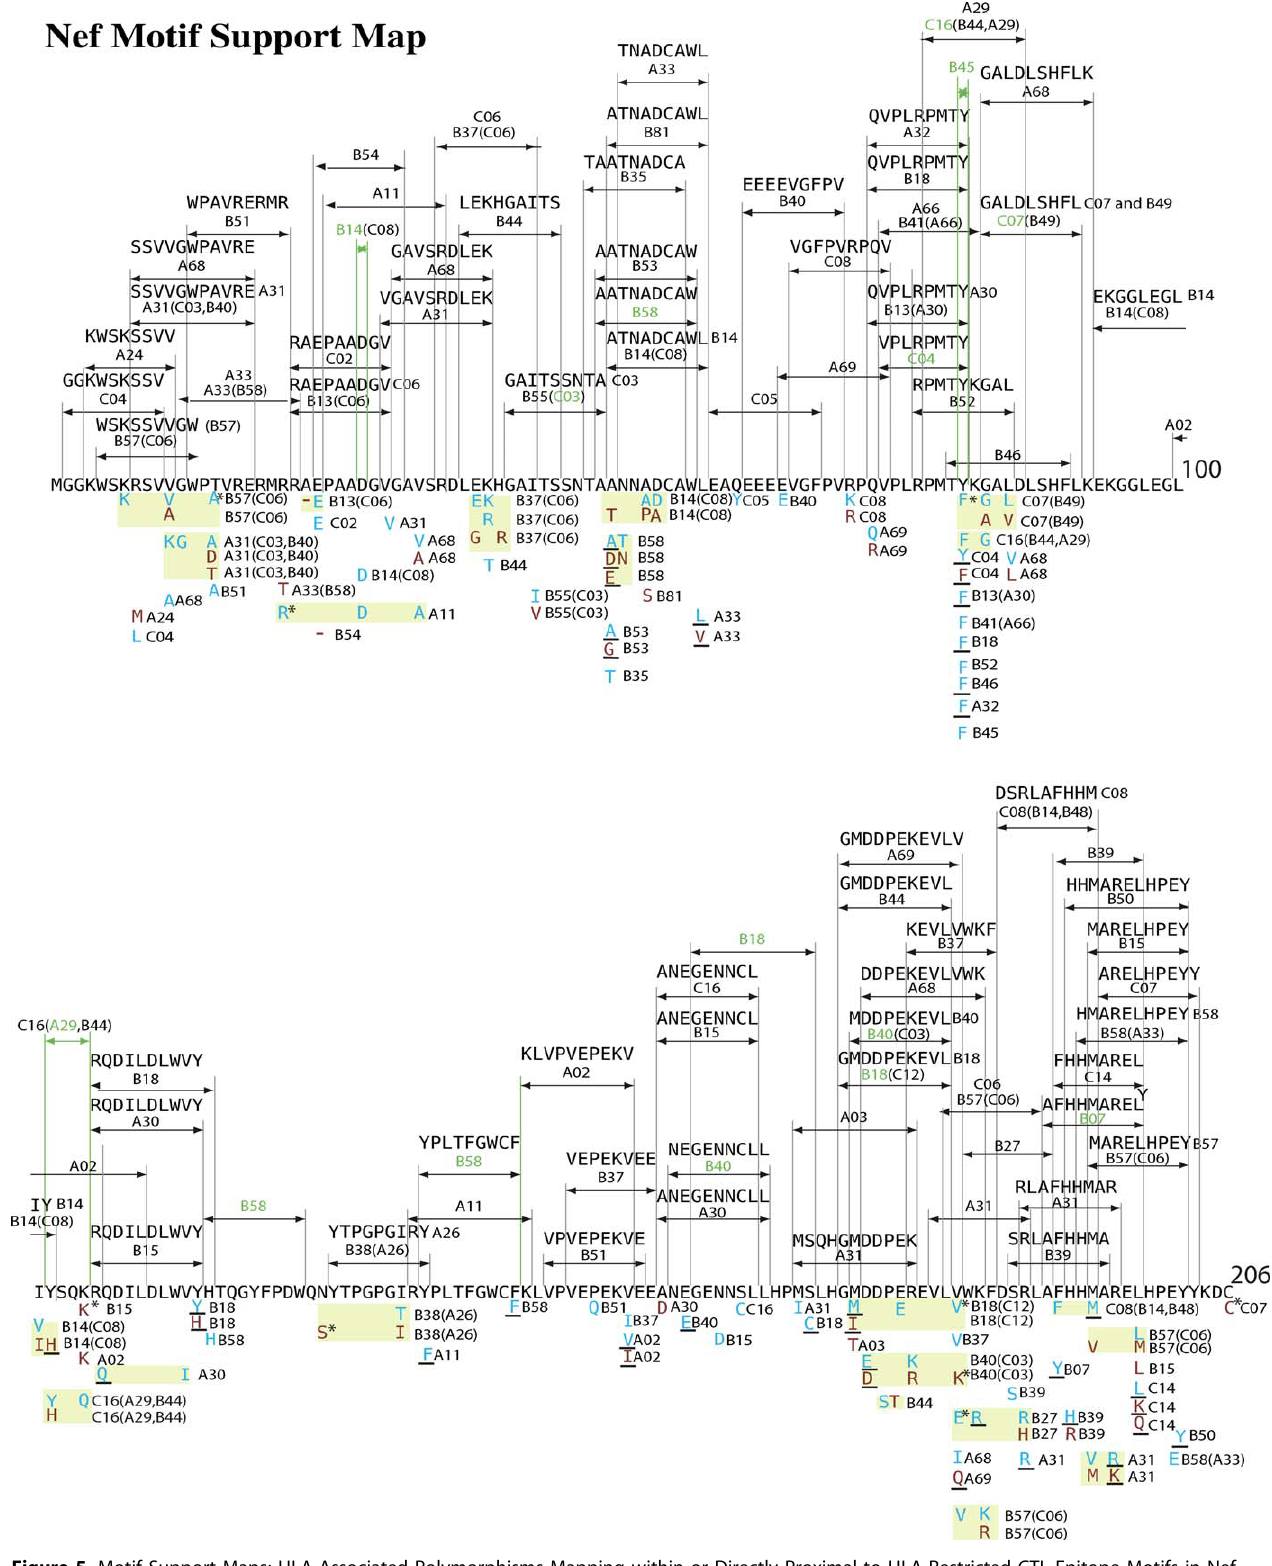
Figure 5. Motif Support Maps: HLA-Associated Polymorphisms Mapping within or Directly Proximal to HLA-Restricted CTL Epitope Motifs in Nef HLA-associated polymorphisms occurring within or directly proximal to ( 6 3 aa) known HLA-restricted epitope anchor residue motifs in Nef are shown. Polymorphisms associated with the same HLA allele(s) occurring within or directly proximal to ( 6 3 aa) of HLA-restricted epitope anchor residue motifs are boxed together in yellow. Predicted epitopes (where available) are indicated above the epitope boundary arrow, while HLA-restricted epitope motif boundaries are simply marked by their corresponding HLA association. Where multiple overlapping motifs were present, only the most commonly